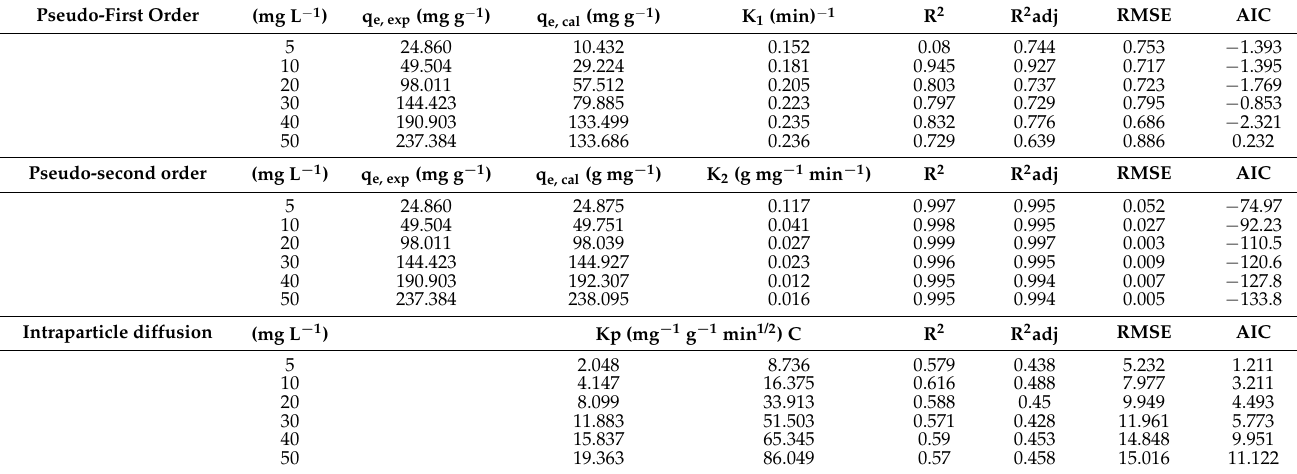
Table 2. Adsorption kinetics parameters for the removal of dicamba.